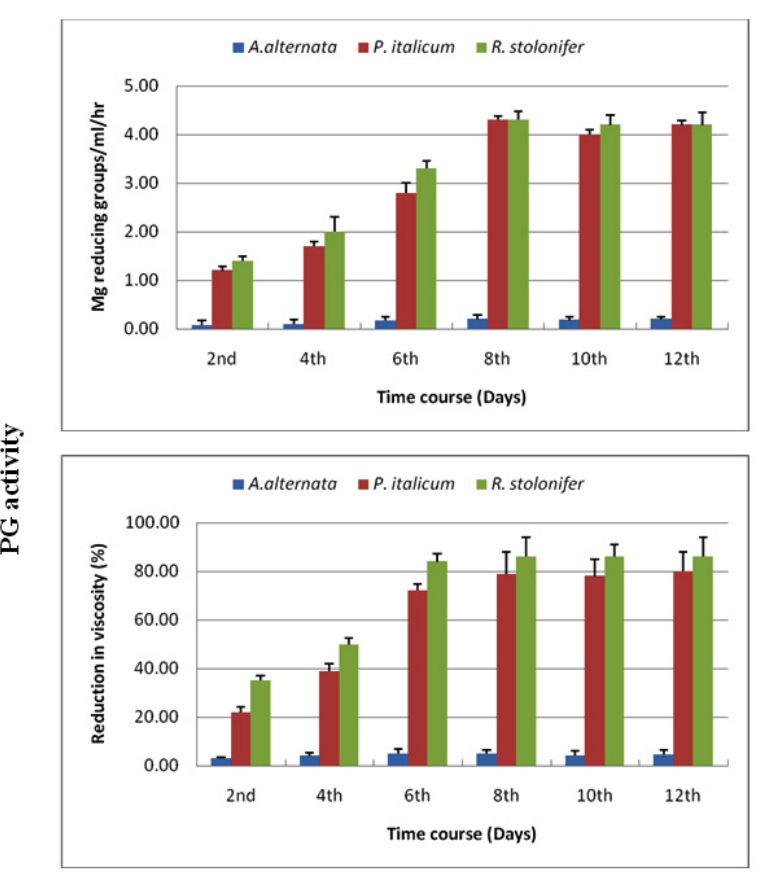
Fig. 2. Time course of production of PG using Czapek Dox medium amended with pectin as carbon source for A. alternata , P. italicum and R. stolonifer at 28 ºC in the dark. All the data are the mean of three replications and Bar on each column represents the standard